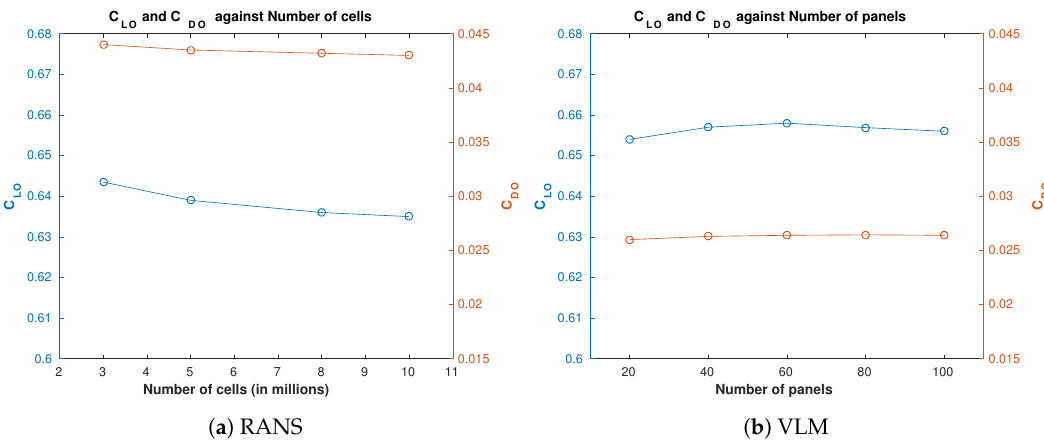
Figure 6. Spatial resolution study for the isolated NACA23012 wing at 8 ◦ angle of attack, in terms of lift ( C LO ) and drag ( C DO ) coefficients for RANS and VLM